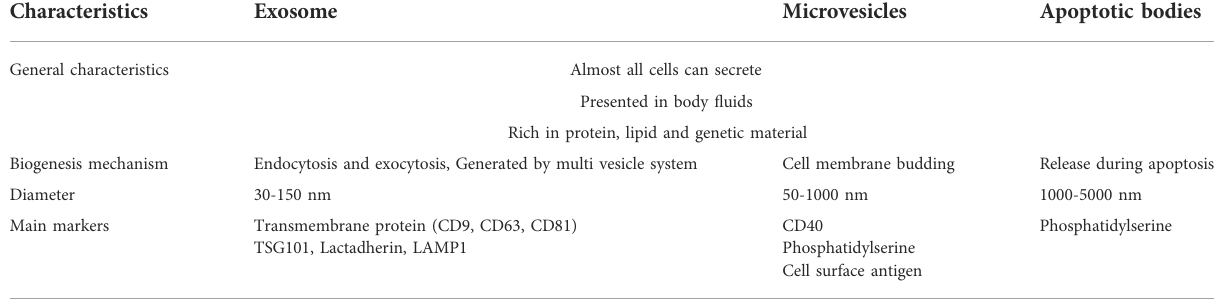
TABLE 1 Comparison of basic physiological characteristics of three kinds of